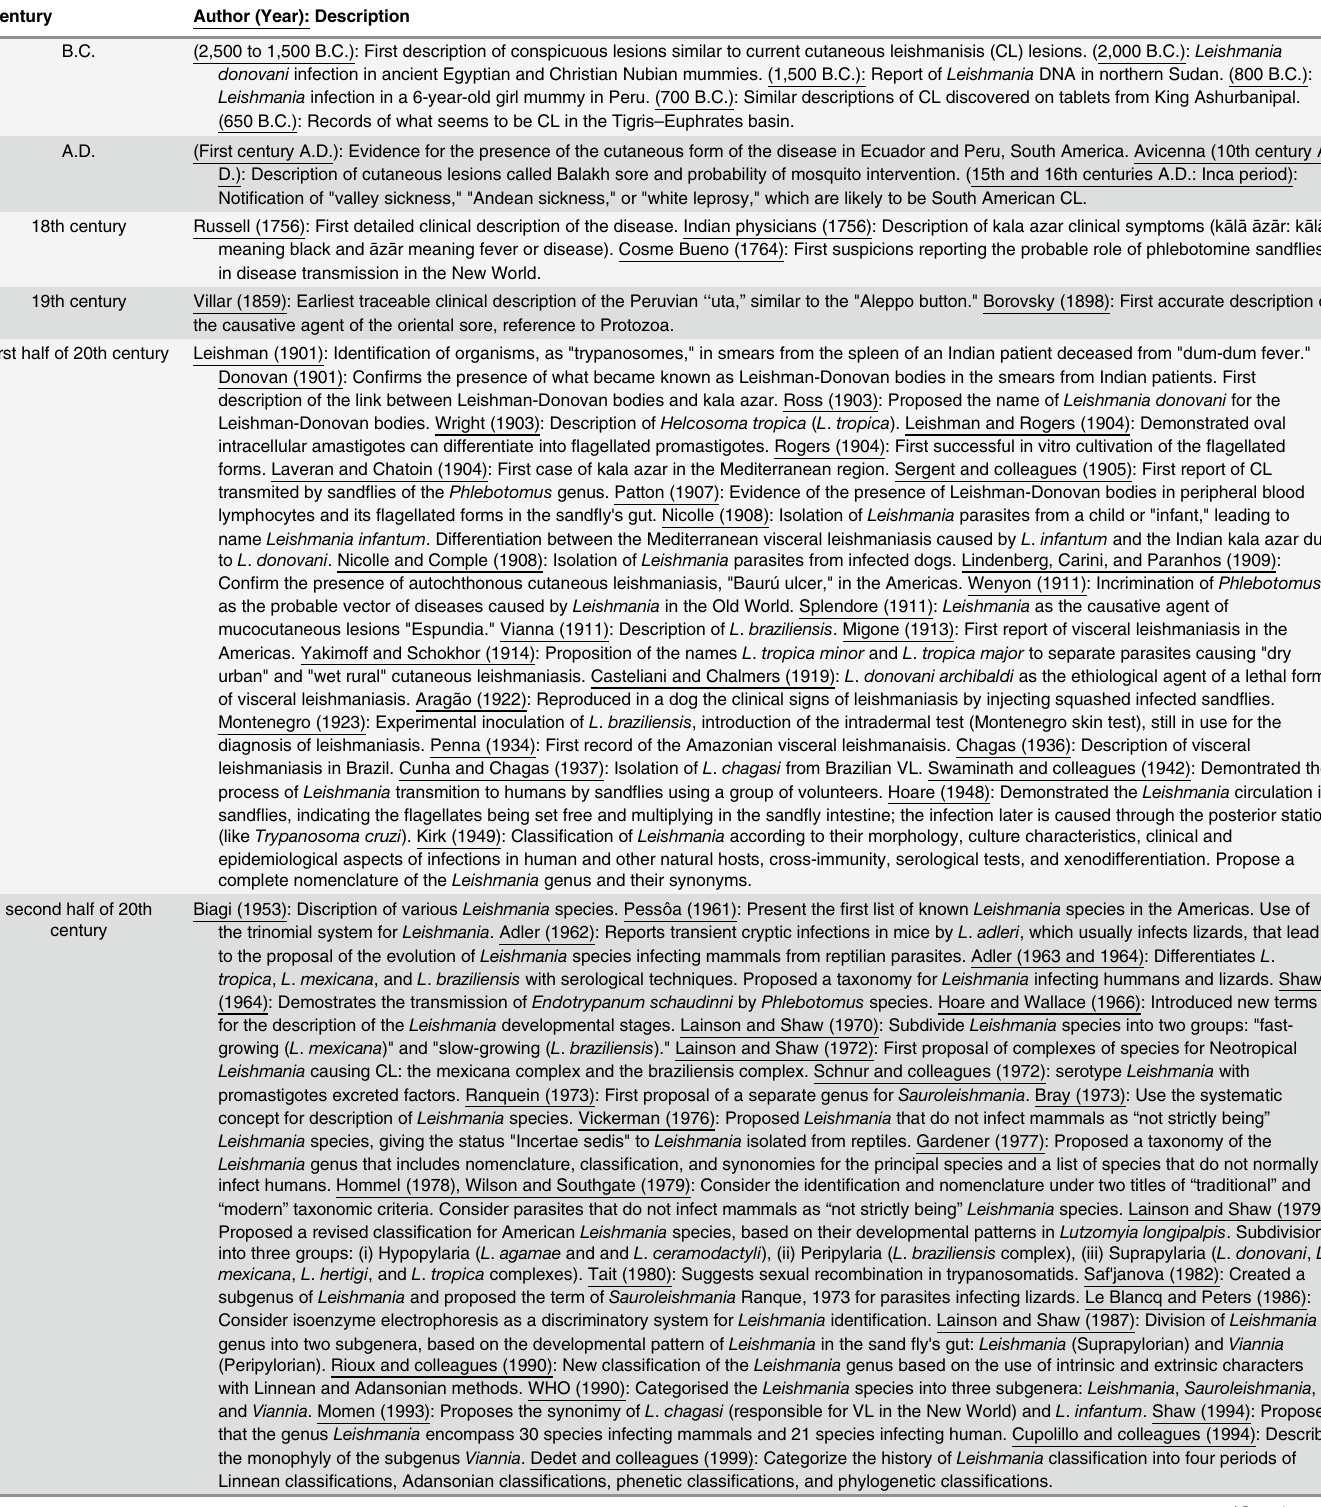
Table 1. History of Leishmania